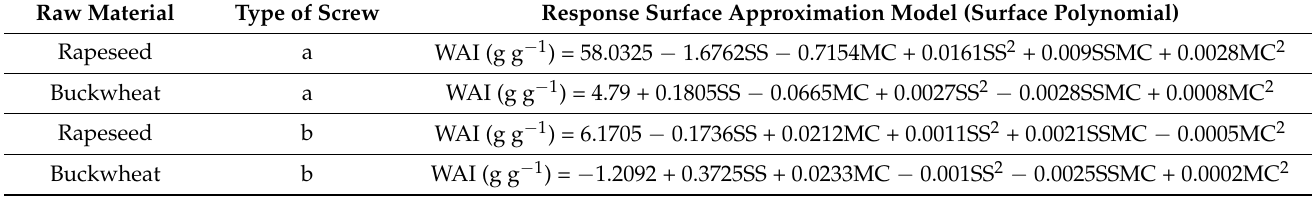
Table 3. Models of response surface approximation for water absorption of extruded rapeseed and buckwheat straws depending on the process variables. Response Surface Approximation Model (Surface